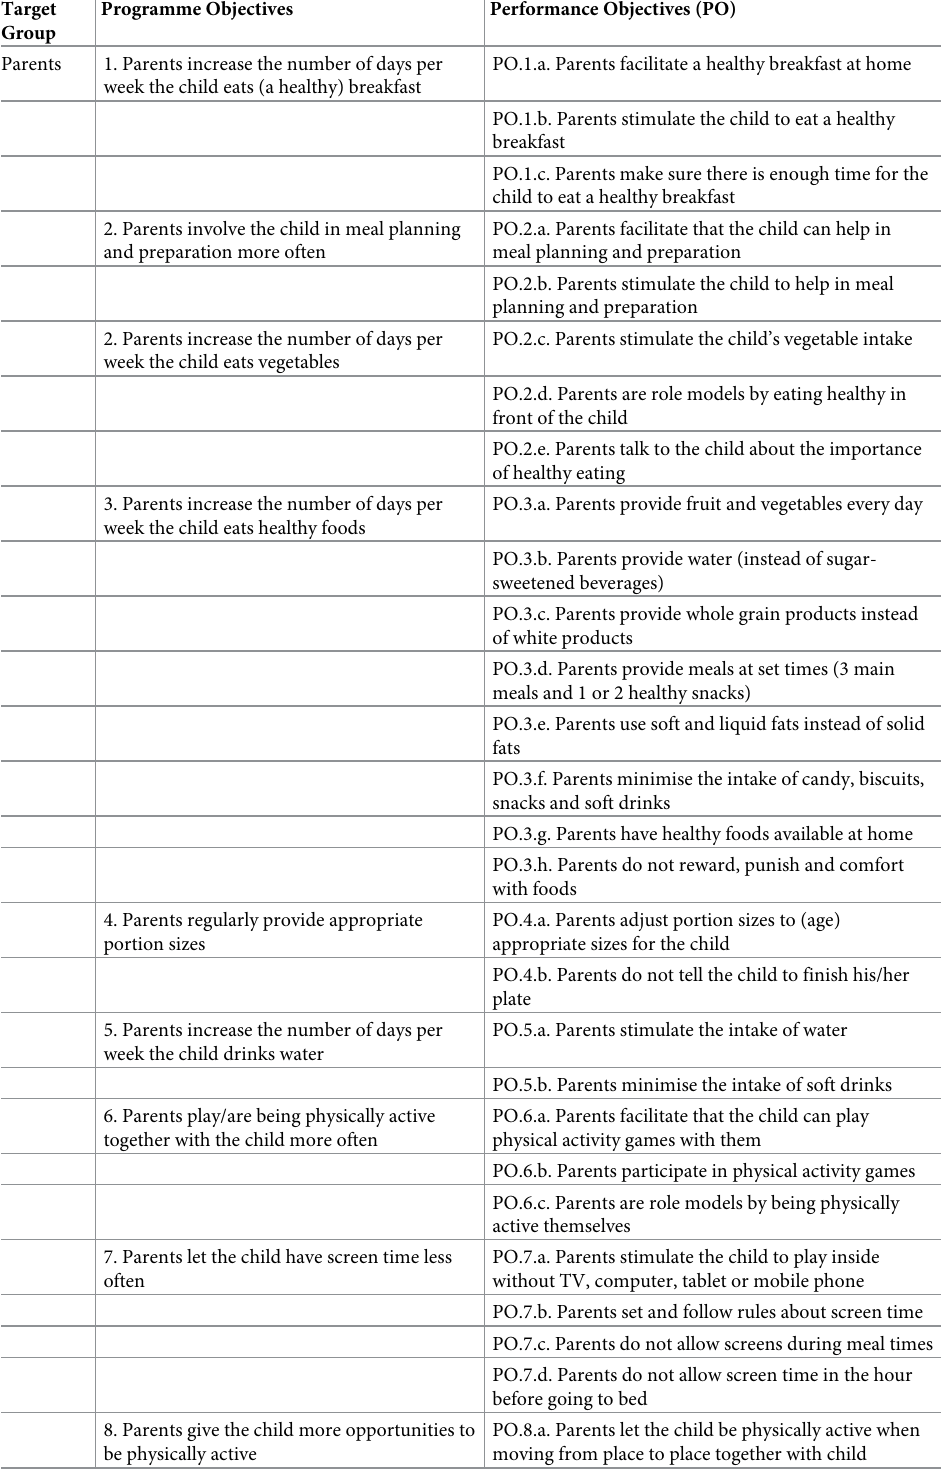
Table 1. Overview of formulated programme and performance objectives for preschoolers’